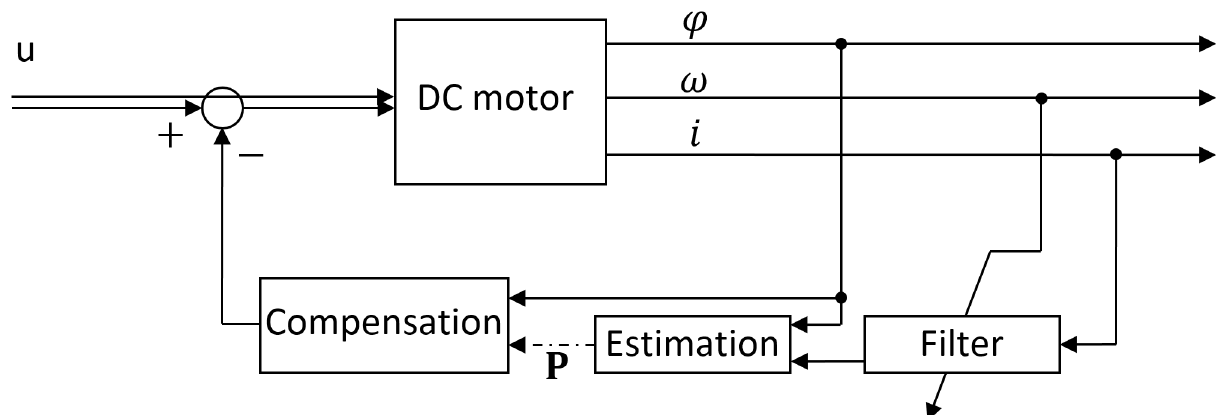
Fig 1. Block diagram of compensation